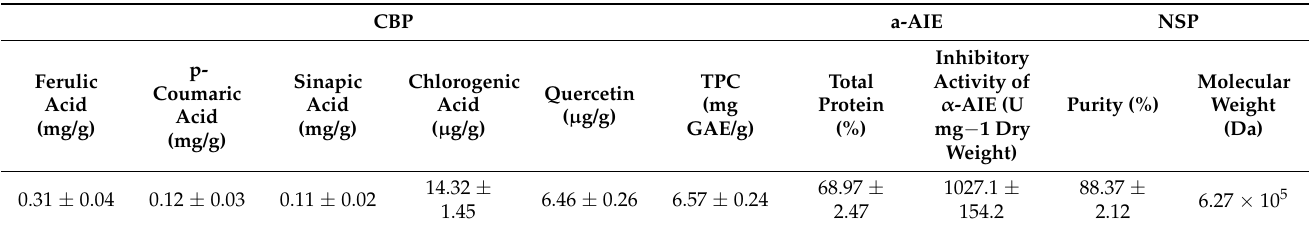
Table 2. The essential information of the common bean polyphenol-rich extract (CBP), α -amylase inhibitor-rich extract (a-AIE) and non-starch polysaccharides-rich extract (NSP) extracted from white common